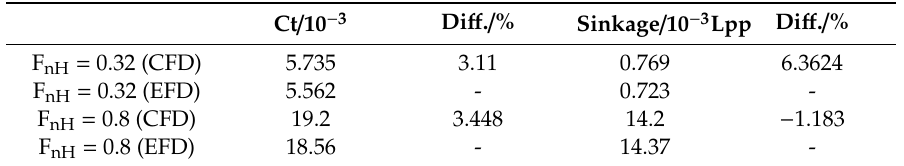
Table 15. The comparison with the experimental value.